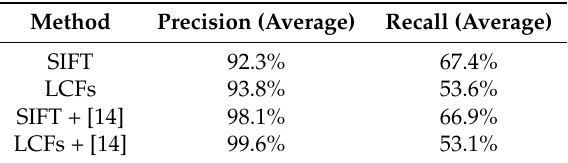
Table 3. Experimental results with outlier removal